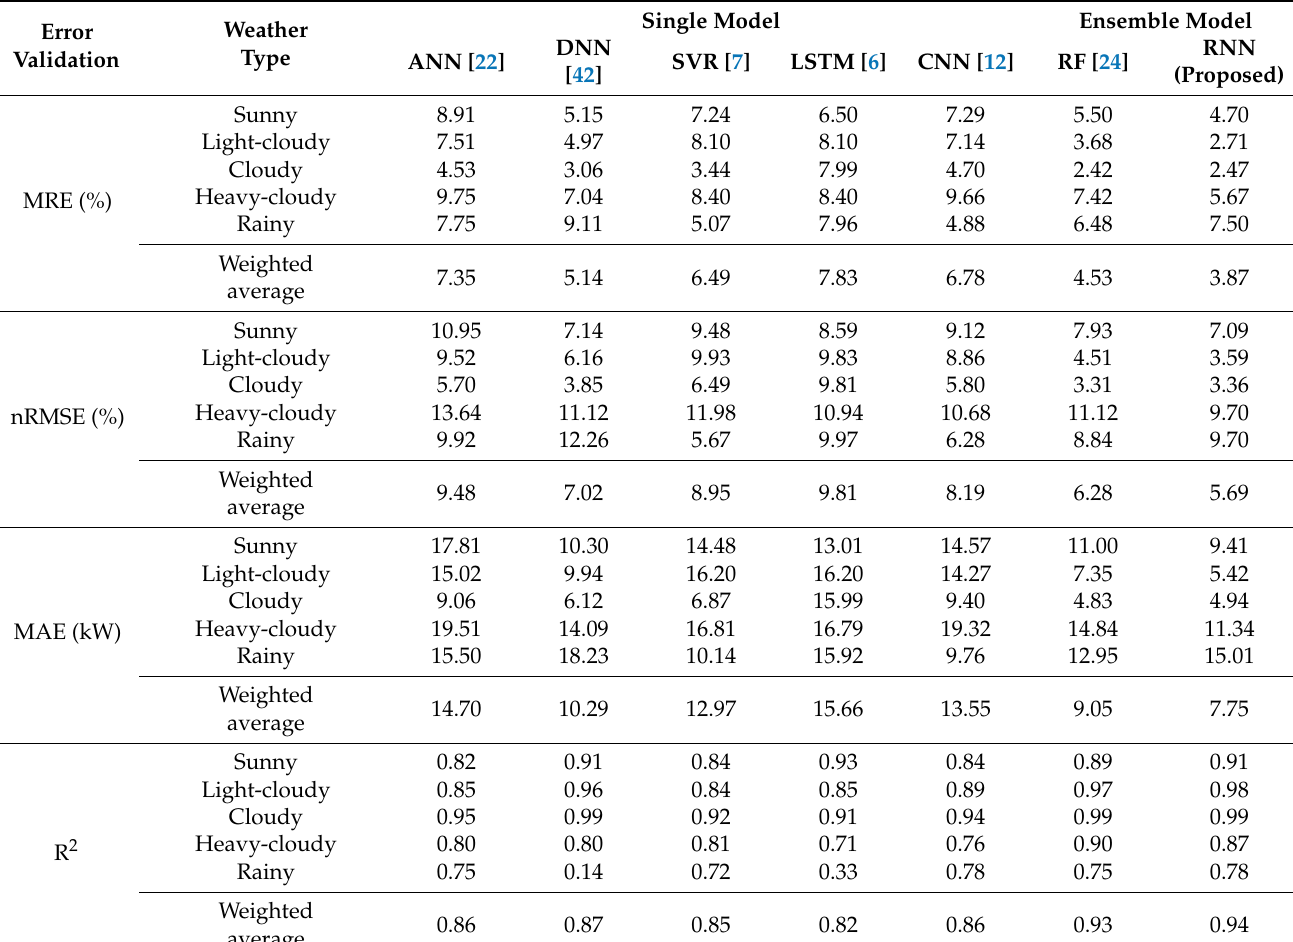
Table 6. One-day ahead hourly forecasting